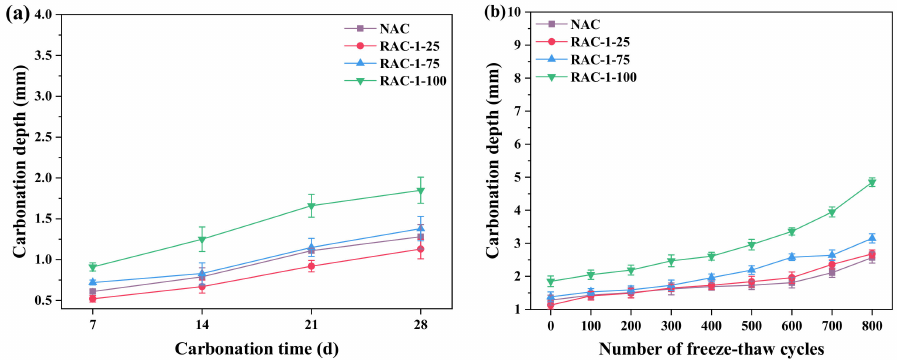
Figure 6. Carbonation depth of RAC-1 with different replacement rates ( a ) before and ( b ) after freeze–thaw cycles.